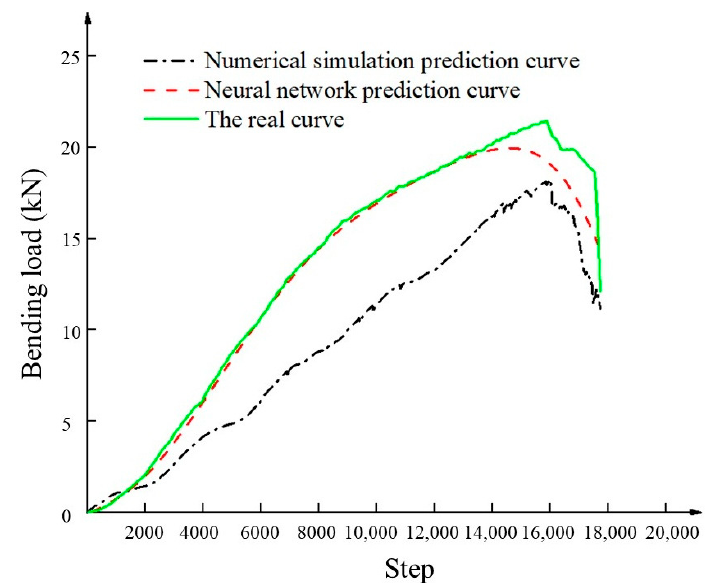
Figure 15. The stress test curve.